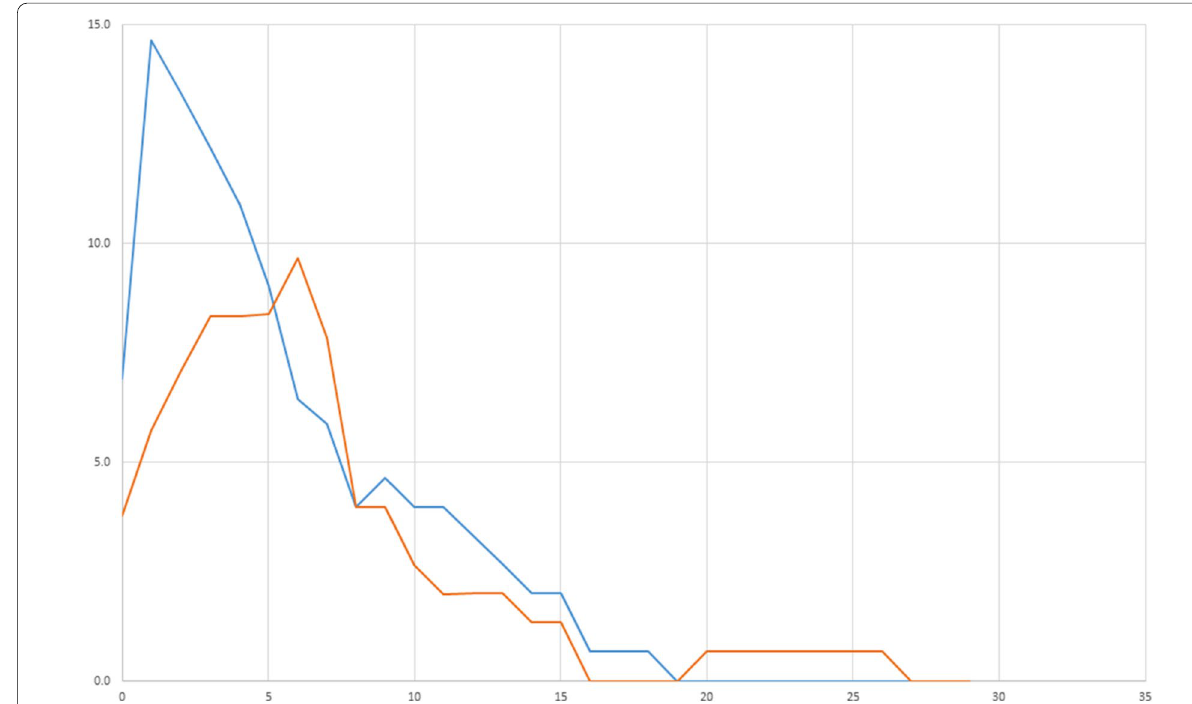
Table 3 Life support therapies and outcomes